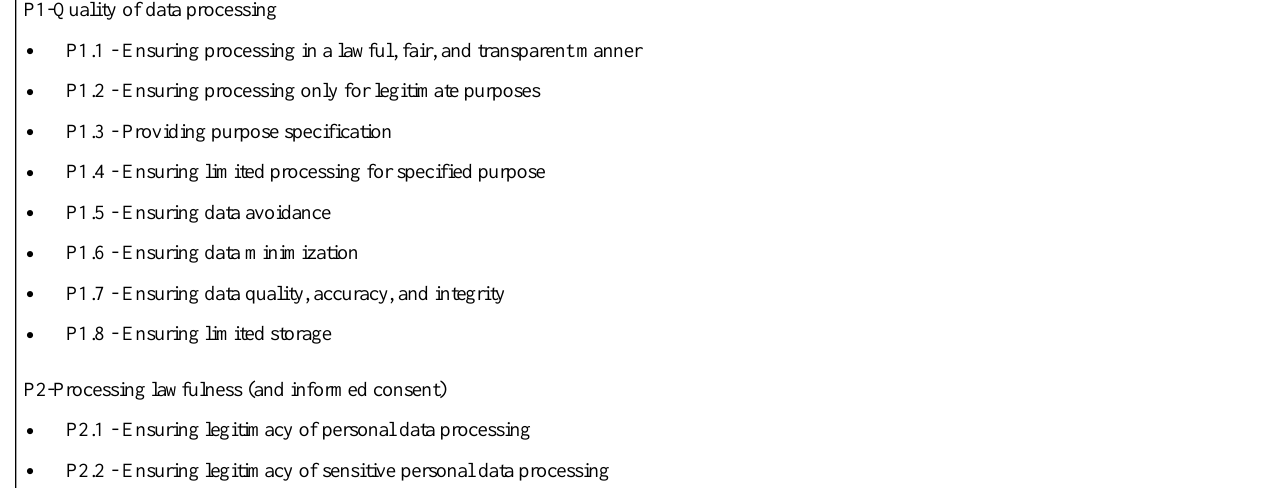
Textbox 1. List of Privacy Principles and Privacy Targets. P1-Quality of data